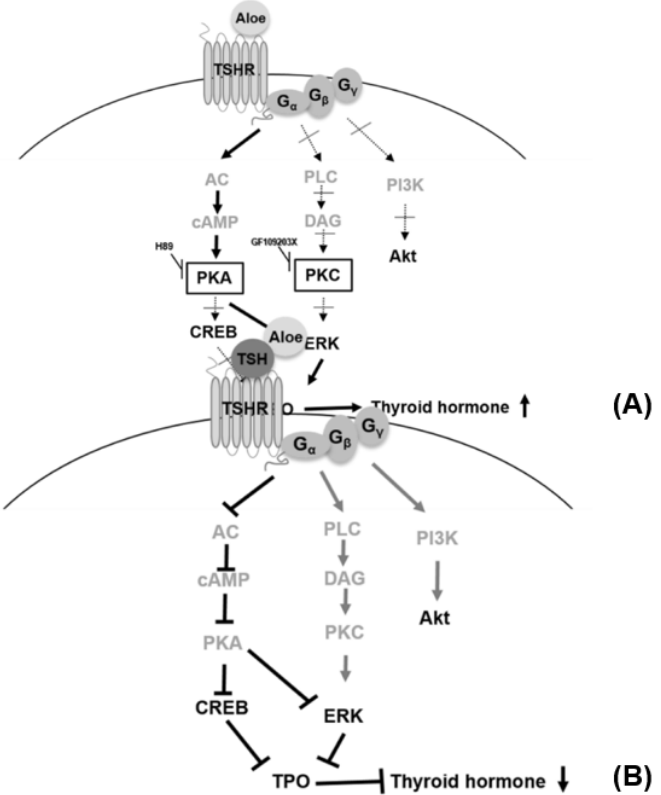
Figure 6. Proposed model showing the pathway by which Aloe (AV) regulate thyroid hormone production in FRTL-5 cells. ( A ) pathways induced by AV in 5H media. AV-induced ERK phosphor- ylation occurs mainly through cAMP-mediated signaling pathways and AV may induce thyroxine release via the PKA/ERK pathway. ( B ) pathways induced by AV in 6H media. AV may reduce